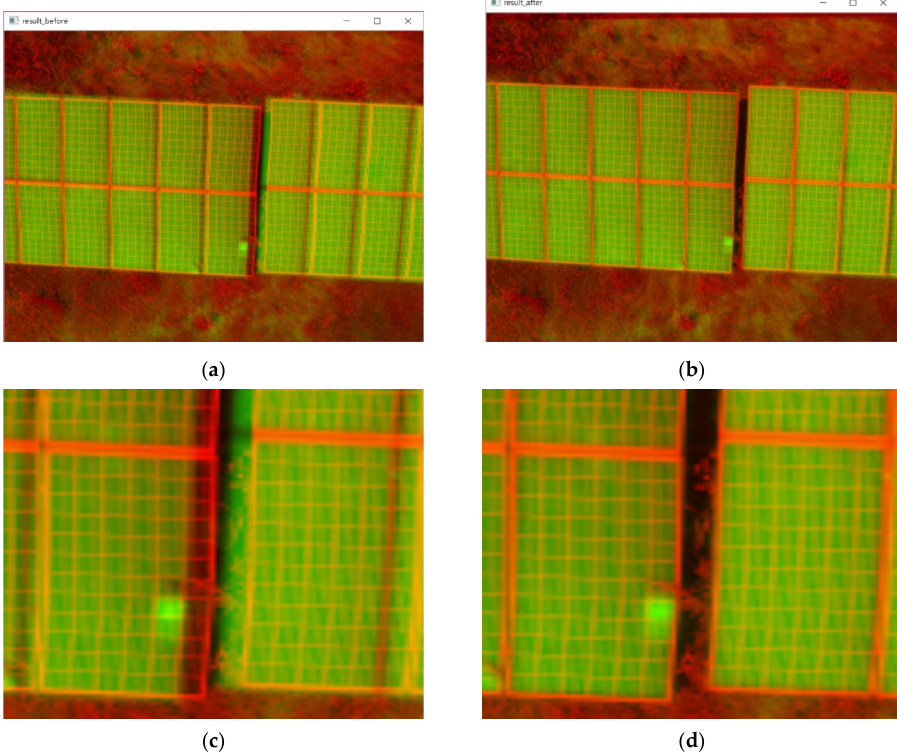
Figure 11. Registration images of visible and thermal using homography: ( a ) registration image without homography; ( b ) registration image with homography; ( c ) enlarged registration image of ( a ); ( d ) enlarge registration image of ( b ).